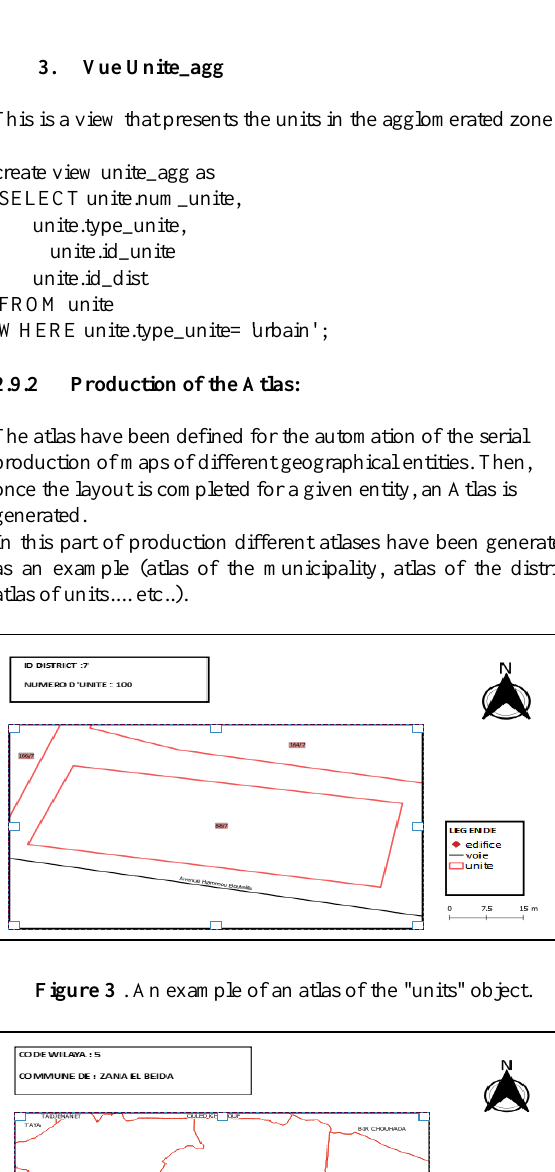
Figure 1. Geometrical details and application of symbology.